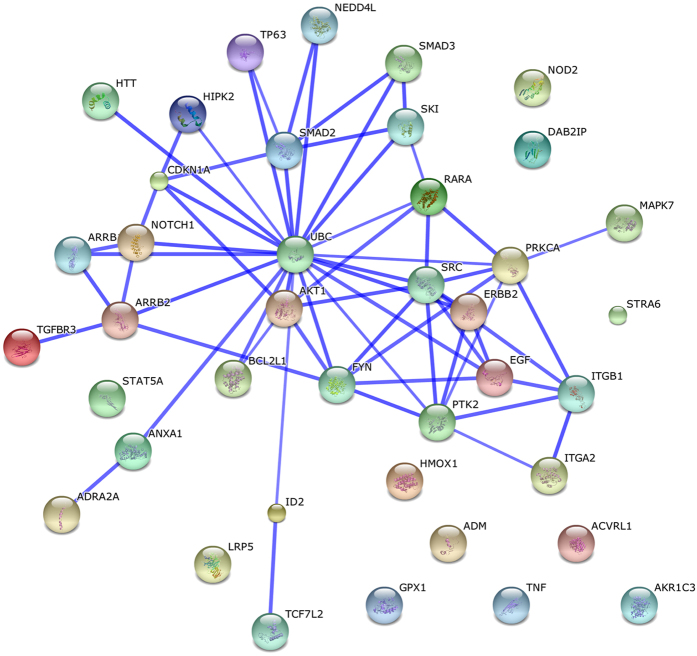
STRING-generated interaction network among the hub genes; the intensity of the edges reflects the strength of evidence; prediction methods: co-expression, experimentally observed interactions and curated databases; confidence score “high” (>70% probability of terms being found together in a metabolic map in the KEGG database).